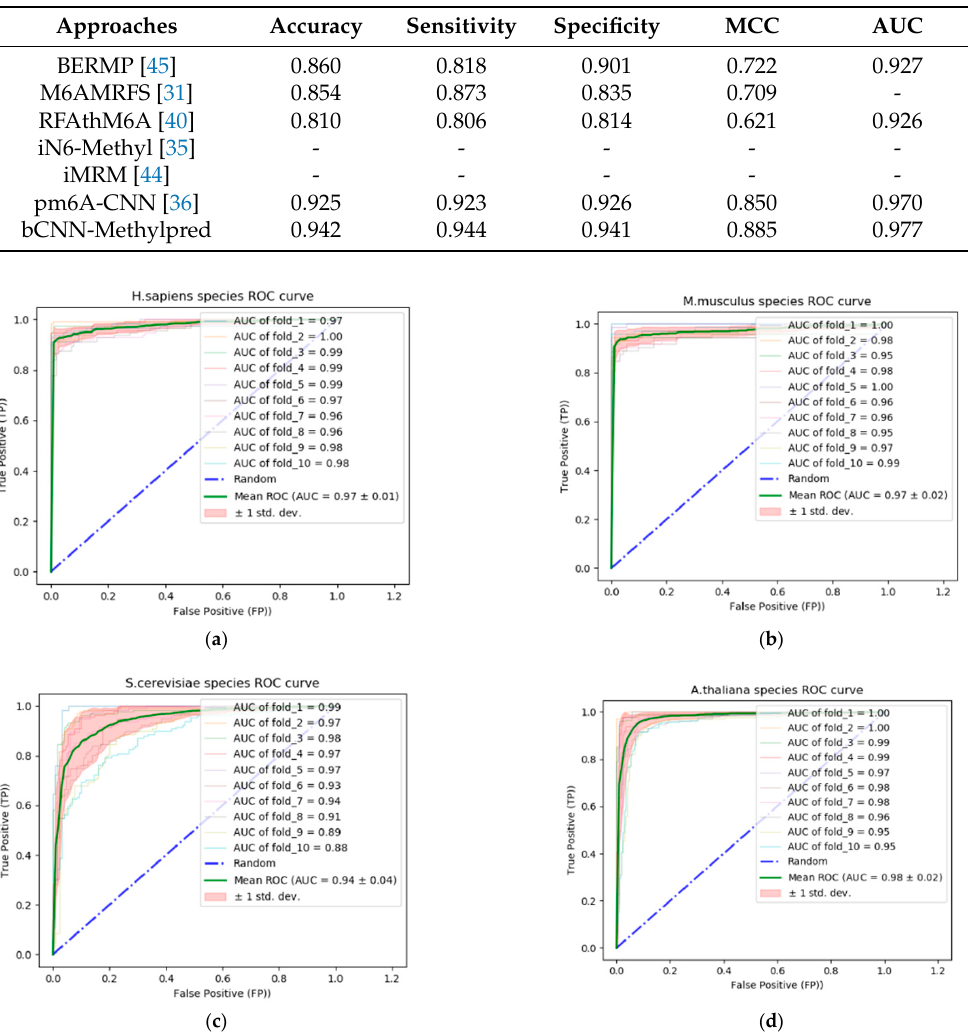
Figure 3. auROC curve of the proposed approach for four different benchmark datasets: H. sapiens , M. musculus , S. cerevisiae , and A. thaliana . ( a , b ) show auROC curves of the proposed approach for H. sapiens and M. musculus species. ( c , d ) show auROC curves for S. cerevisiae and A. thaliana